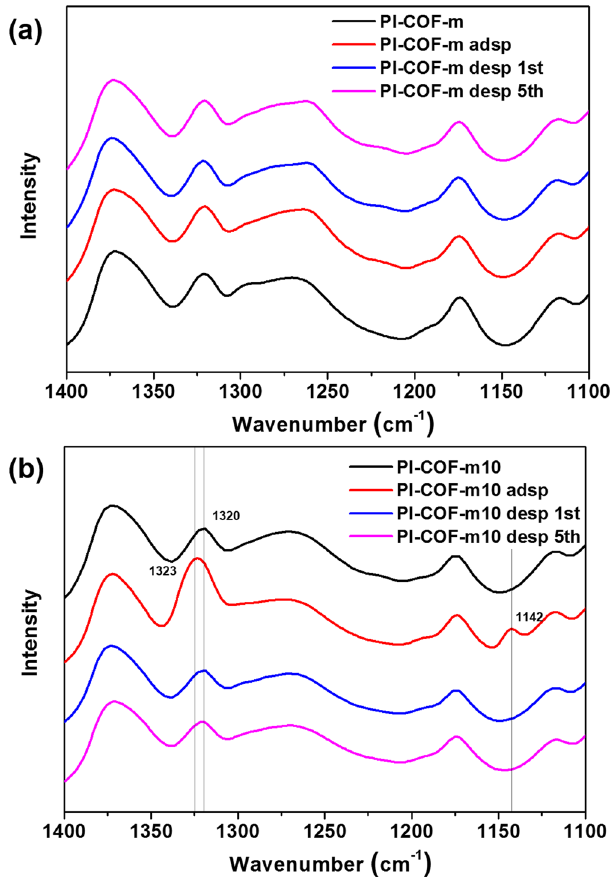
Figure 6. FT-IR spectra of PI-COF-m and PI-COF-m10 after SO 2 sorption-desorption processing. FT-IR spectra of fresh, SO 2 -loaded, regenerated, and 5 th regenerated ( a ) PI-COF-m and ( b ) PI-COF-m10.